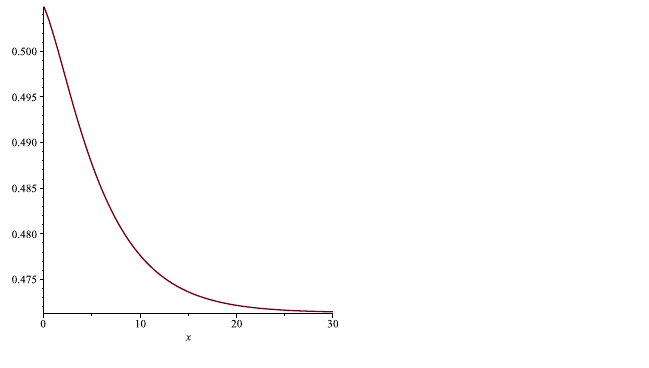
Figure 5. Approximation u ∗∗ ( x , 1) to the optimal control u ∗ ( x , 1) in the interval [0 , 30] when the first 9 terms are used in the